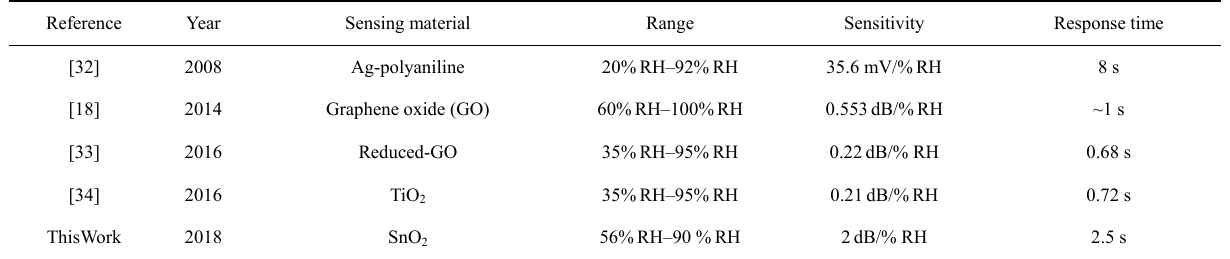
Table 2 Comparison between various materials of planar optical waveguide as humidity sensor for interval 2008 − 2018.